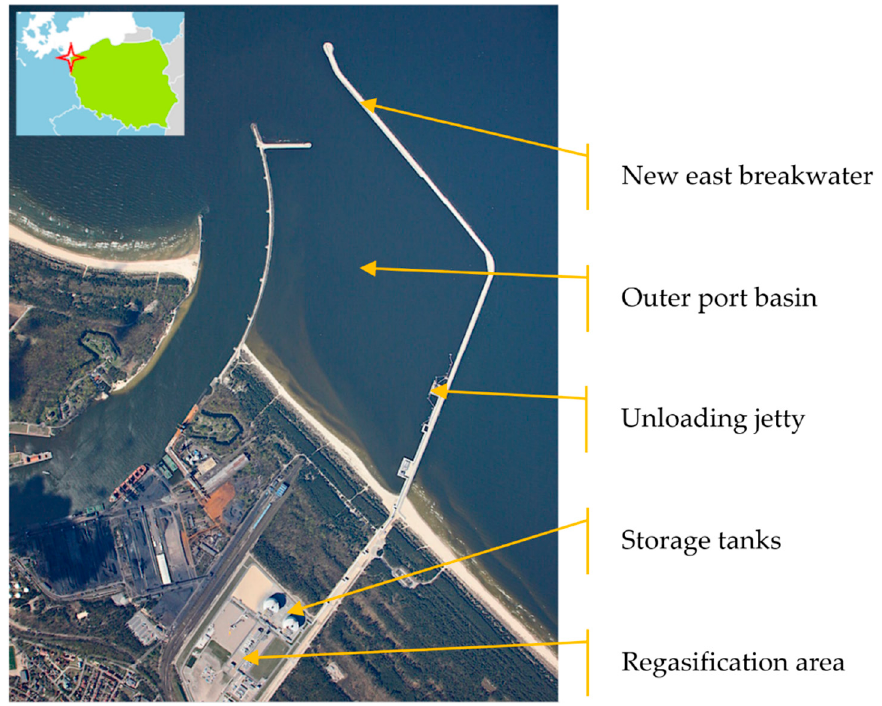
Figure 9. LNG terminal in Ś winouj ś cie—the location and main facilities (based on